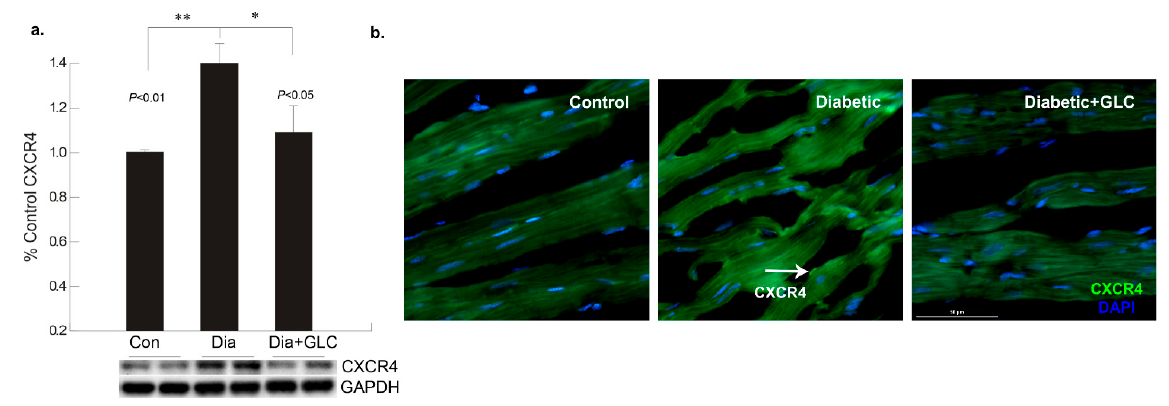
Figure 3. Increase in chemokine receptor CXCR4 expression in the diabetic heart tissue was reduced after 4 weeks of GLC treatment. ( a ) Chemokine receptor CXCR4 expression was increased significantly the ventricular tissue of ZDF rats compared to lean control animals as demonstrated by Western blot analysis (** p < 0.01) and treatment with GLC revealed alteration in the expression of CXCR4 (* p < 0.05). ( b ) Immunohistochemical illustrations further confirmed the decrease in the CXCR4 expression by GLC treatment in the diabetic animals compared to diabetic group; arrow indicates CXCR4 positive staining (Scale bar = 50 µm).